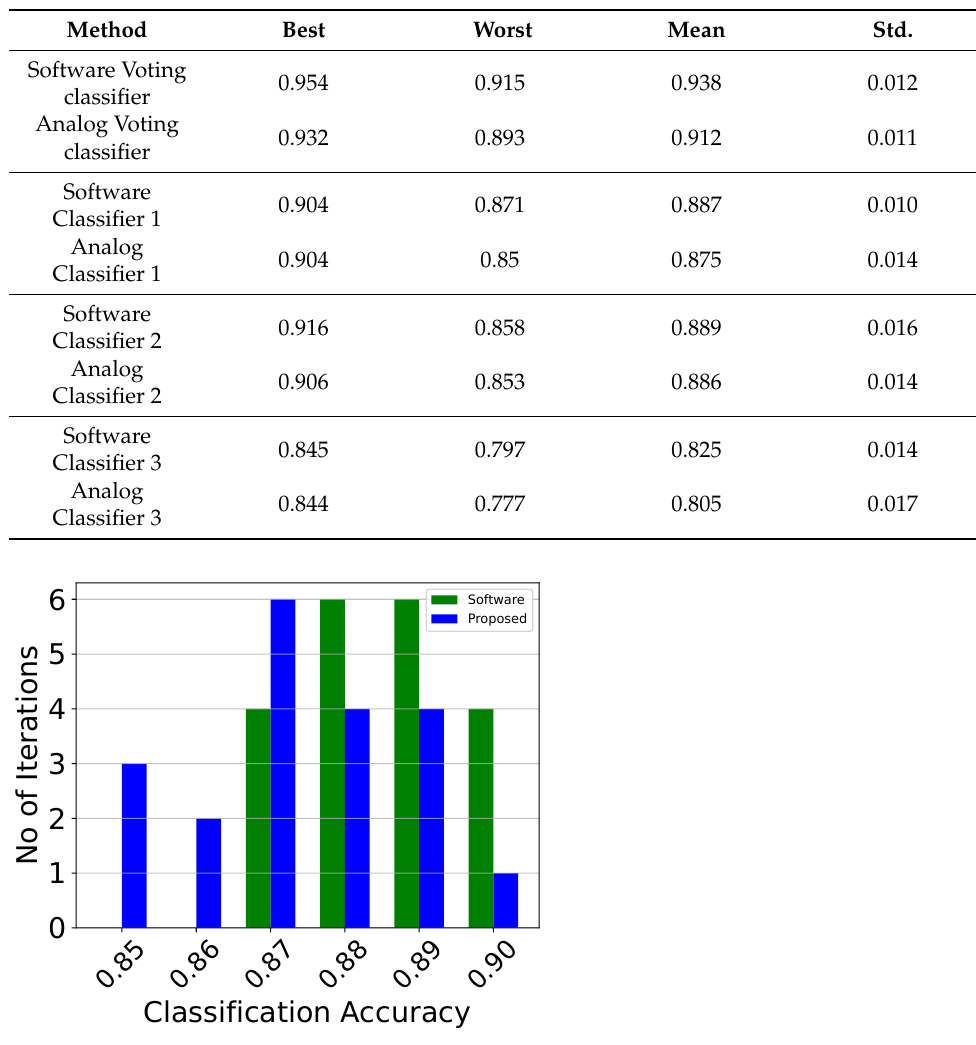
Figure 12. Classification accuracy histogram of the analog centroid-based classifier attached to the first electrode (classifier 1) over 20 iterations.